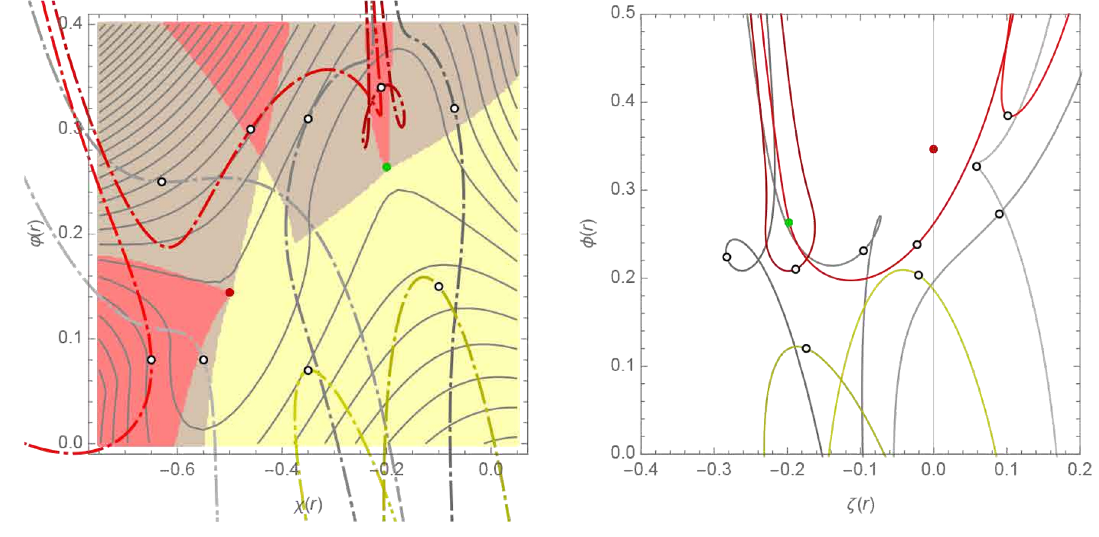
Figure 10. Space of generic N = 1 Janus solutions with SU(3) symmetry. Red and green dots represent U(3) and G 2 critical points,